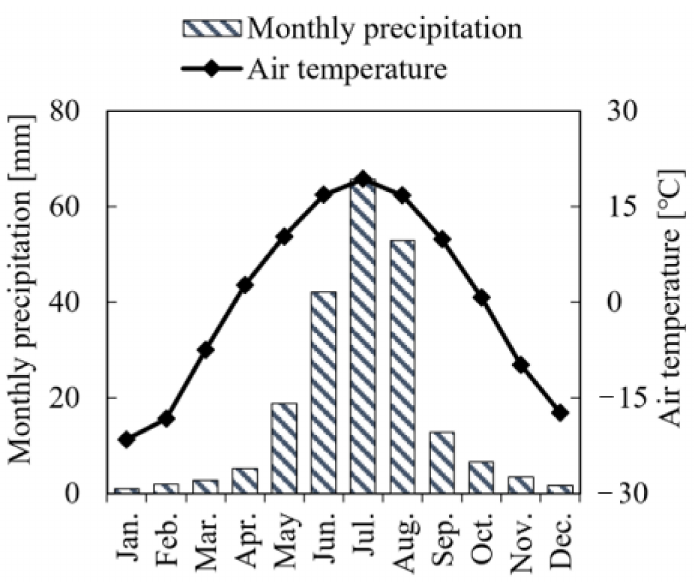
Figure 3. Monthly average precipitation and air temperature obtained from a weather station